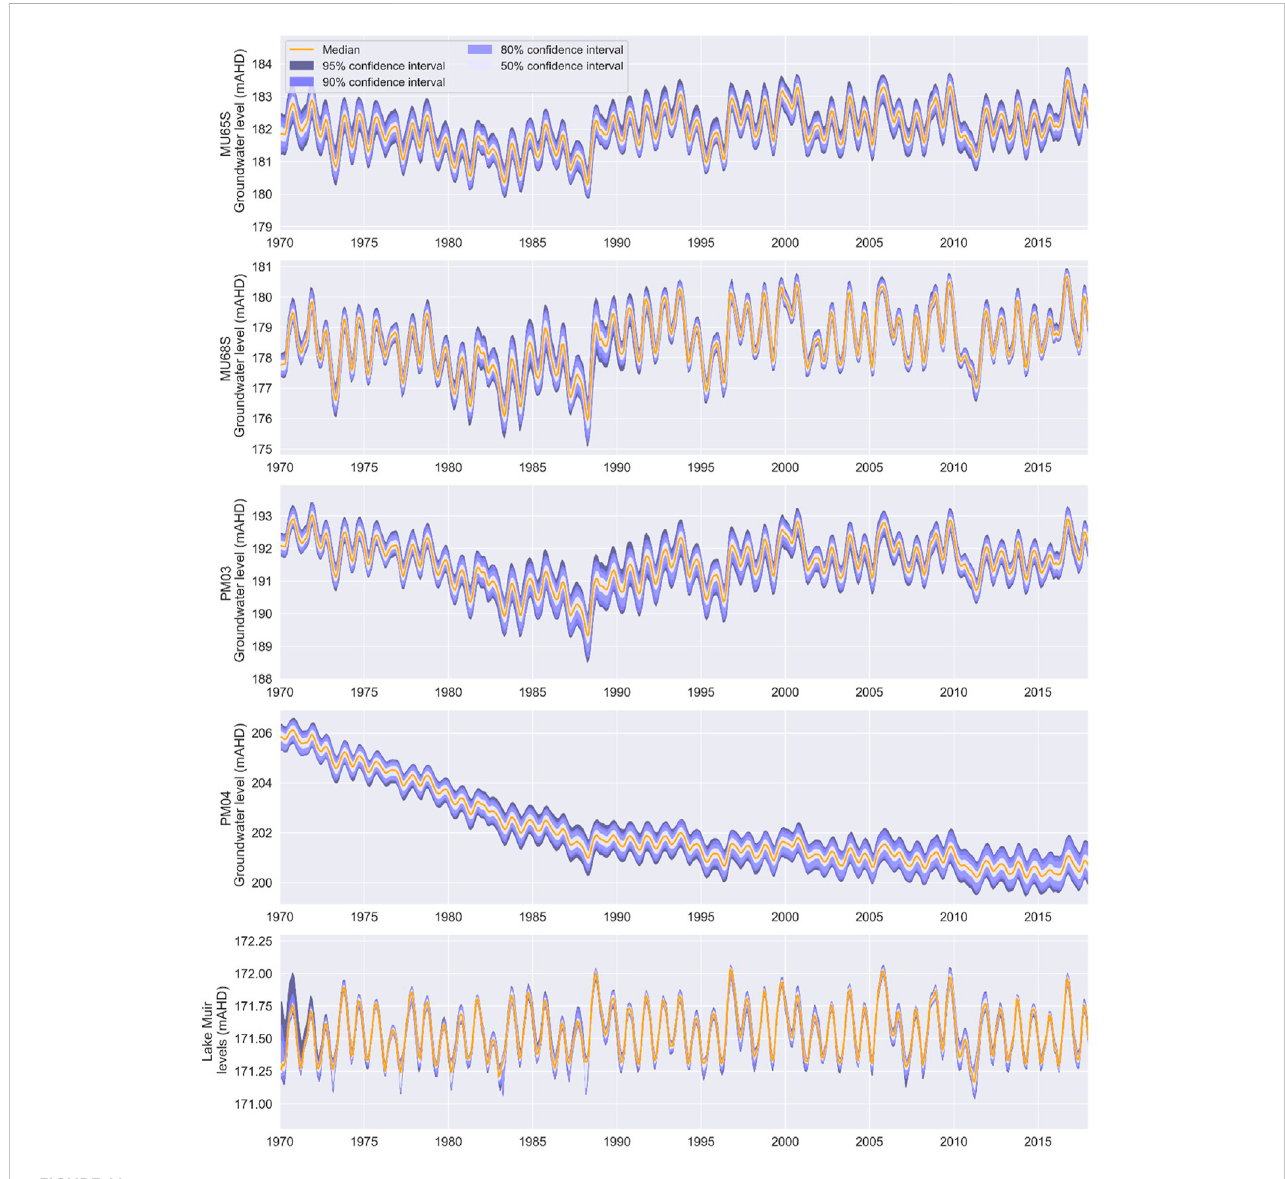
FIGURE 11 Simulated lake and groundwater level ensemble percentiles at selected